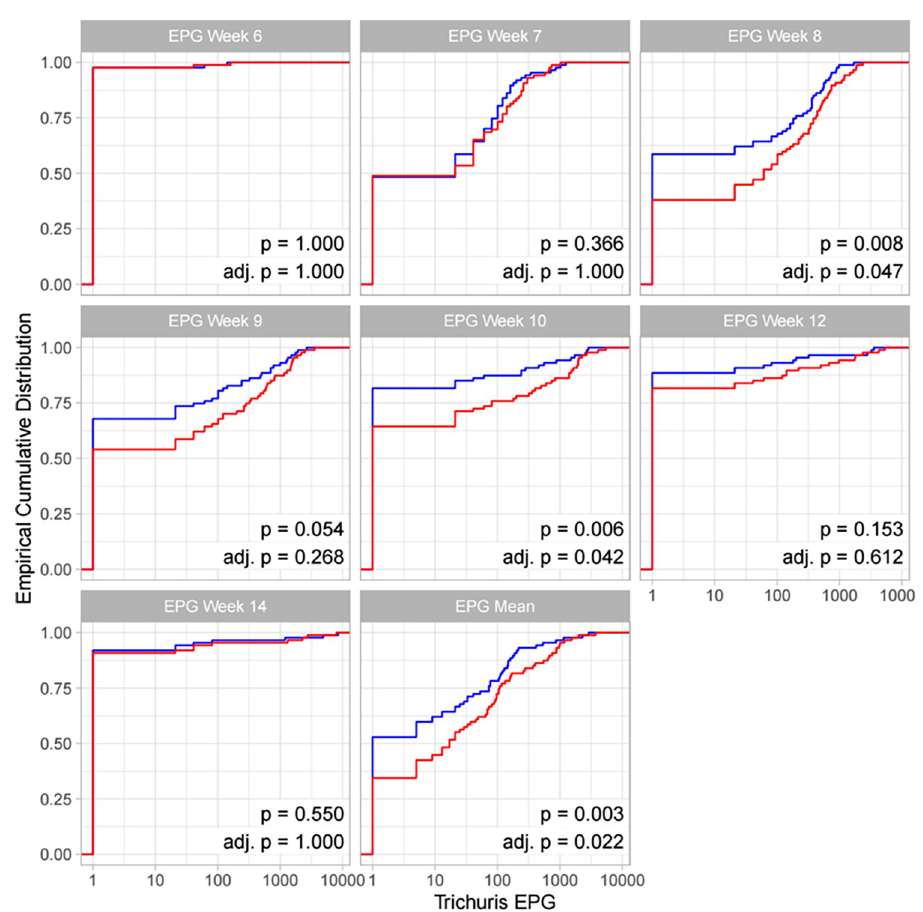
Fig 1. Empirical cumulative distribution function plots of Trichuris suis EPG at each time point (EPG week 6–14) and mean EPG throughout time course (EPG mean) for low weight gain animals (red) compared to high weight gain animals (blue) grouped by pig weight gains at weeks 0–14 (n = 174). p-values based on Wilcoxon signed rank tests are given in addition to the same p-values adjusted according to Holm’s method (Holm, 1979)